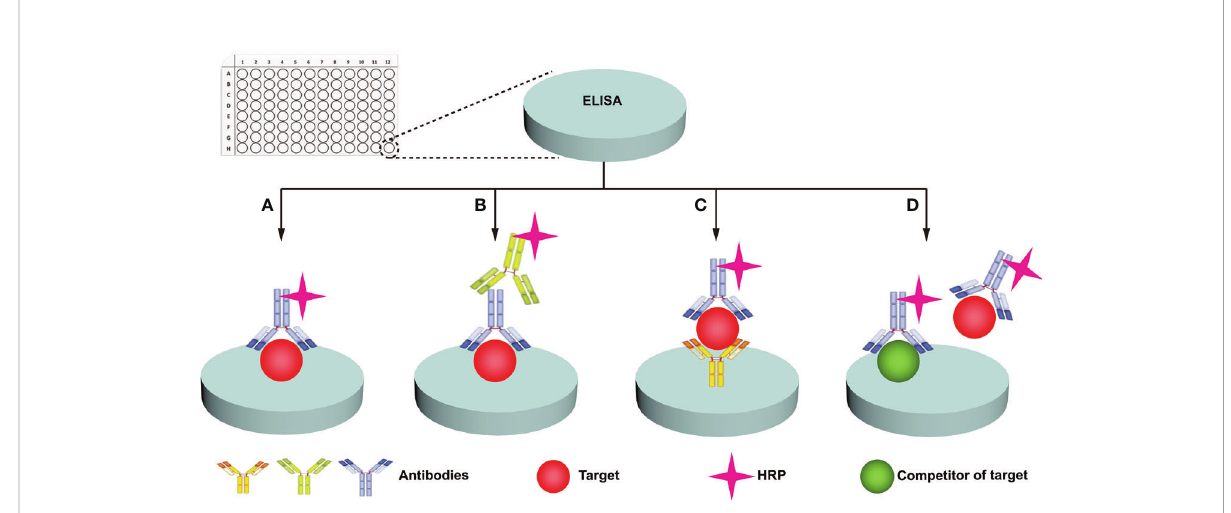
FIGURE 3 ELISA analysis of protein glycosylation. Four main types of ELISA assays are used: direct (A) , indirect (B) , sandwich (C) , and competition (D) .